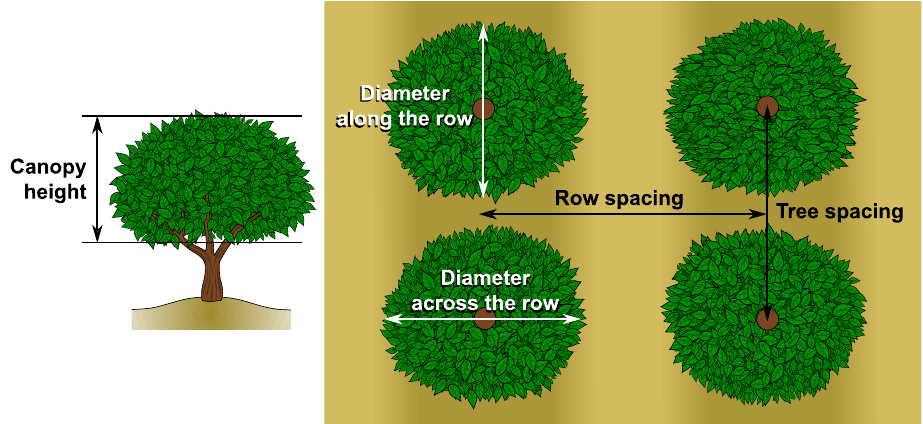
Figure 1. Required parameters to obtain the adjusted volume in the CitrusVol calculator.